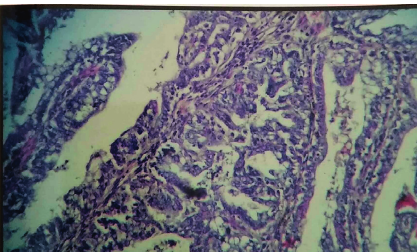
Figure 8: Histopathological appearance of mammary tumor showed multiple ductlike structures filled with coalescing multibranched papillae.